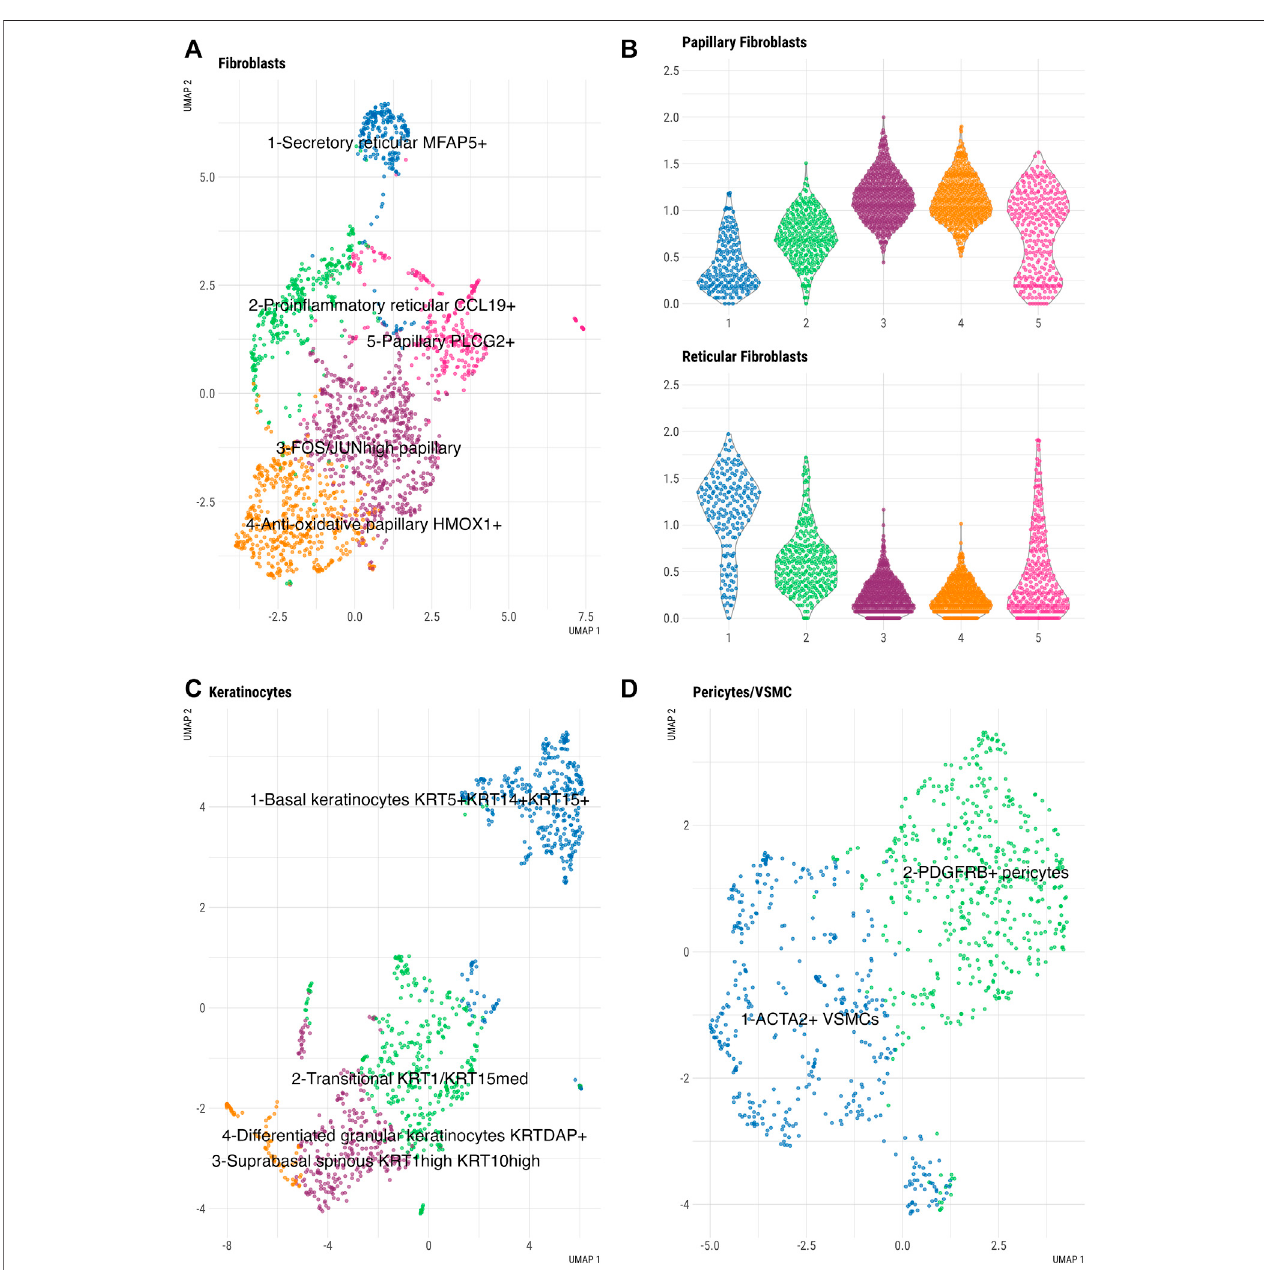
FIGURE 3 | Subclustering analysis of large skin cell populations in freshly dissociated skin. (A) UMAP of fi broblast subclusters (B) Violin plots of averaged expression ofthe genes constituting the papillary (top panel) and reticular (bottom panel) gene signatures (See Supplementary Figure S5A for the list of genes) across the fi ve fi broblastclusters.x-axisdepictscellclusternumberandy-axisrepresentsaverageexpressionofeachsetofgenesusinglog-normalizedUMIcounts. (C) UMAP of keratinocyte subclusters and (D) UMAP of pericytes/VSMCs subclusters.